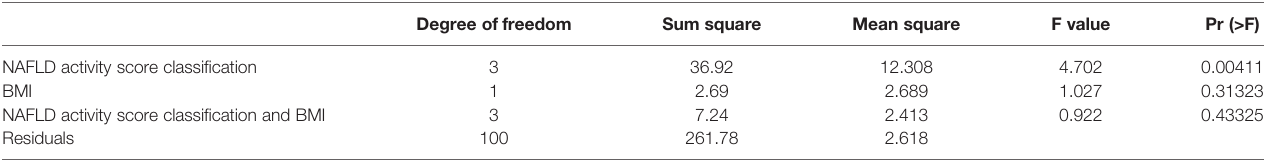
TABLE 1 | The statistical results of the two main effects based on the multiway